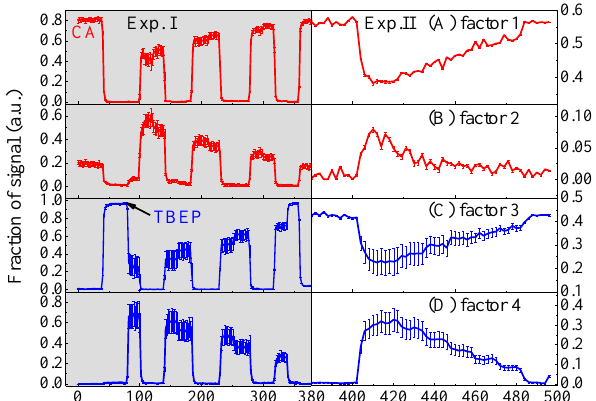
Figure 4. Typical temporal concentration profiles of the four-factor solution for oxidation of externally mixed TBEP-AN and CA par- ticles. On the left side, the curves are the same as those in Fig. 1 (exp. I); the oxidation of externally mixed TBEP-AN and CA as function of OH concentrations is represented in the right side (exp.